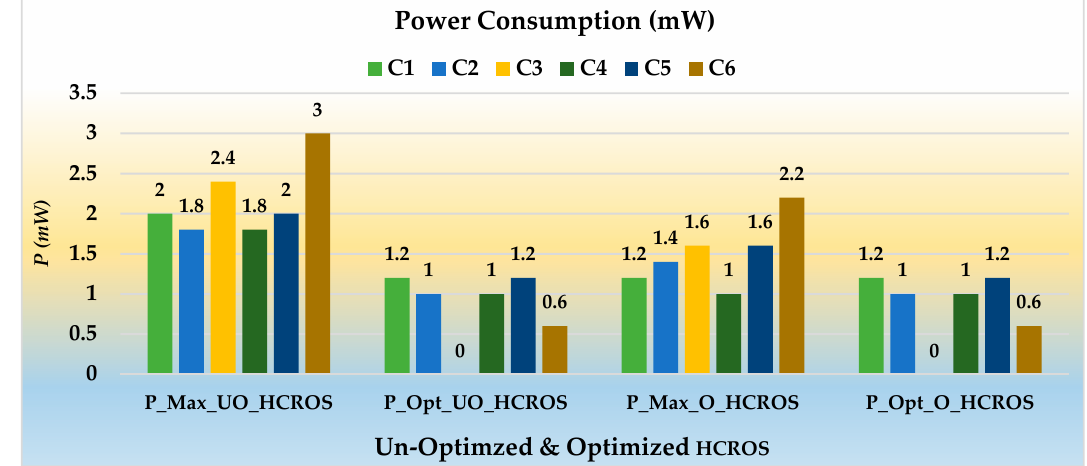
Figure 11. Power consumption P (mW) of un-optimized and optimized HCROS for 6 I/O links .